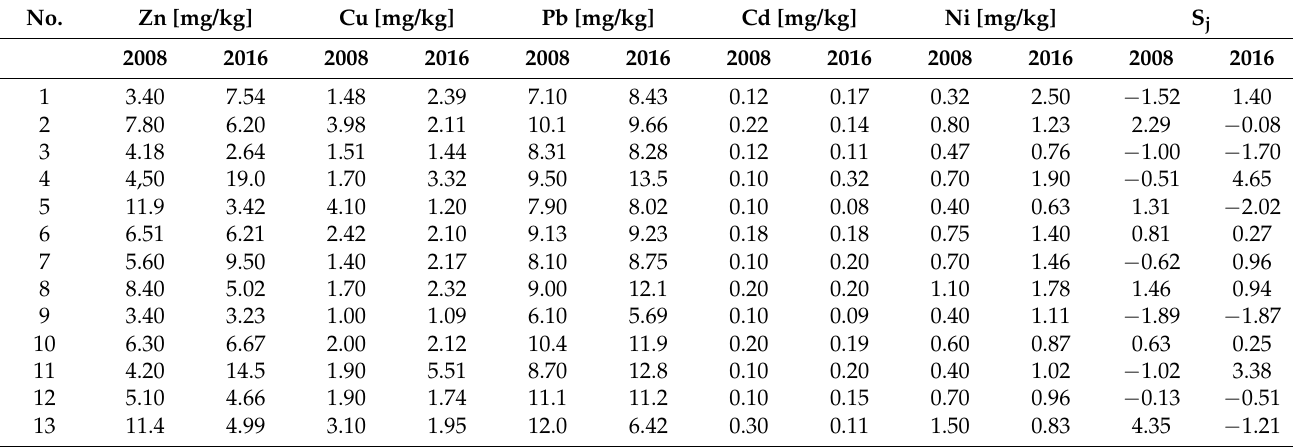
Table 2. Metal contents in soils (extractant 1 mol/L